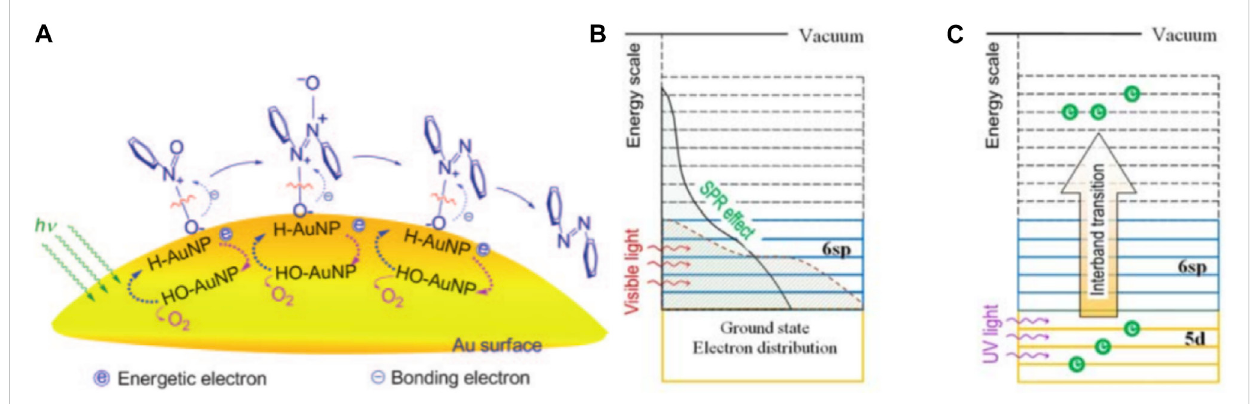
FIGURE 12 (A) Mechanism for the photocatalytic SHN over Au/ZrO 2 , (B) electron excitation in Au nanoparticles due to the LSPR effect when illuminated with visible light, and (C) an interband transition when illuminated with UV light. Reproduced with permission from reference (Zhu et al.,